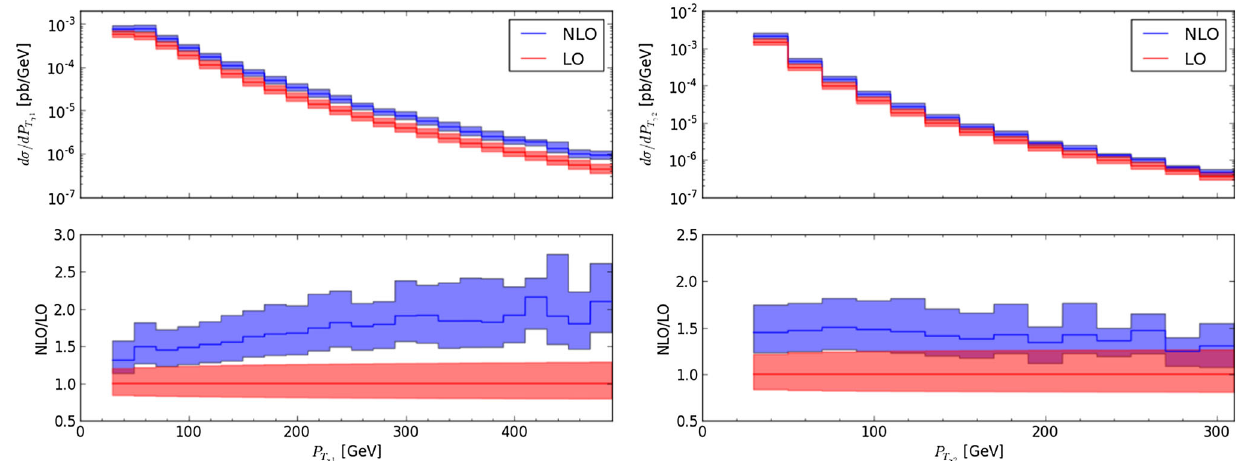
Fig. 3 Transverse momentum of the two